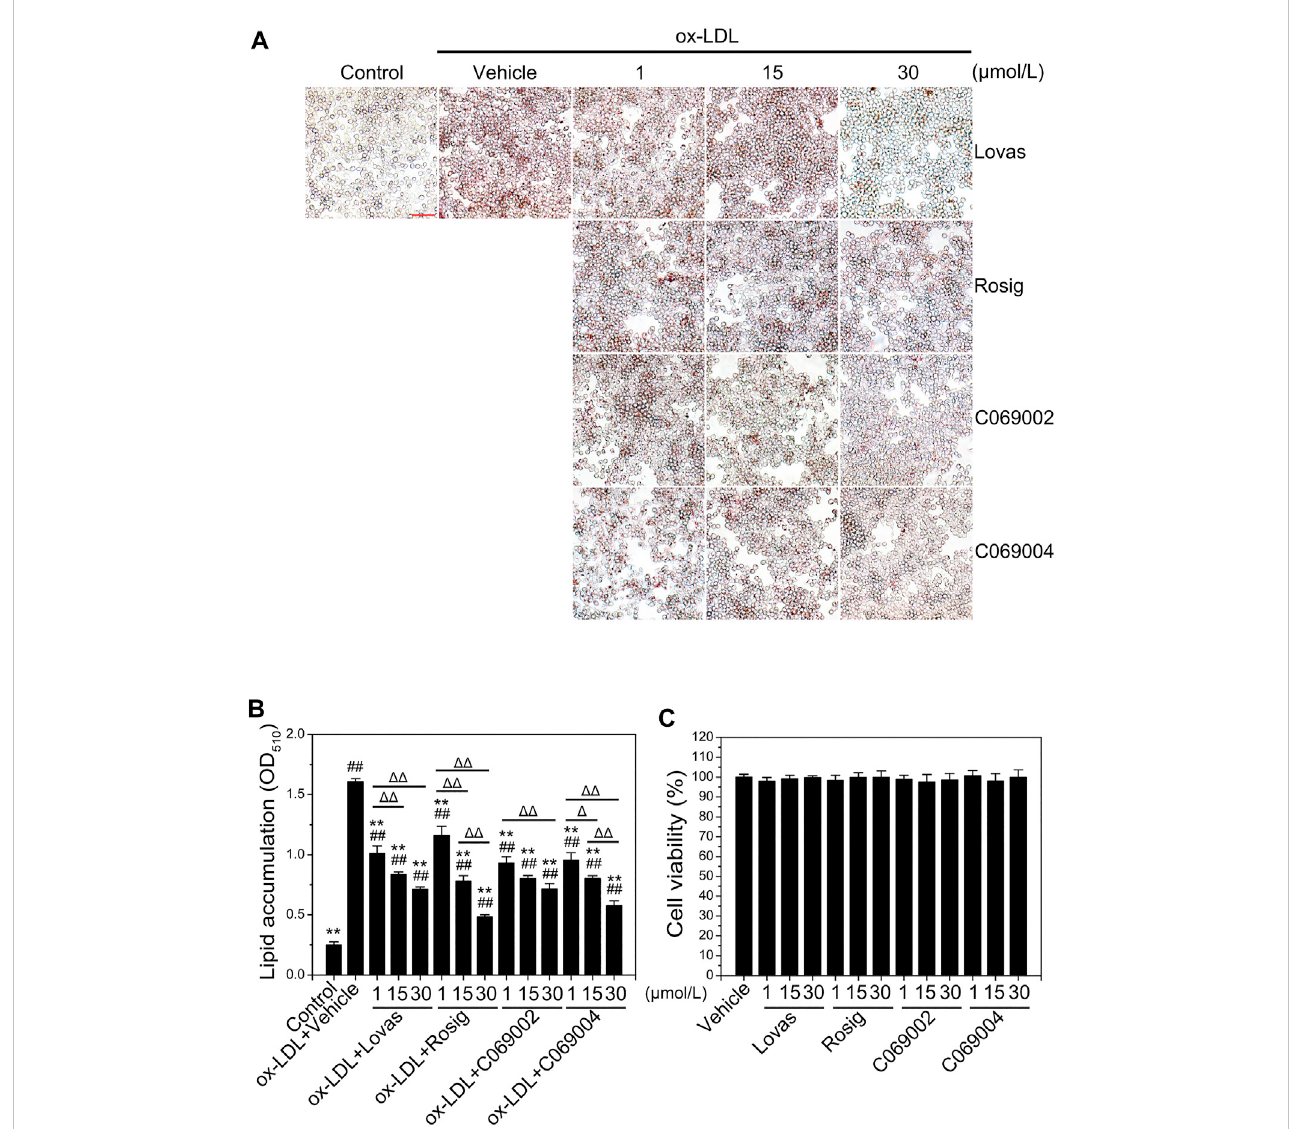
Diterpenoidsalleviateox-LDL-inducedintracellularlipidaccumulationandhavenoeffectonmacrophagecellviability. (A) RAW264.7cellsweretreatedwithox- LDL(80 μ g/mL)anddifferentconcentrationsoflovastatin,rosiglitazoneorditerpenoids(C069002andC069004)for24 h.Lipidaccumulationwasdetermined byoil redO(ORO)staining(×400magni fi cation).Scalebar=50 μ m. (B) QuantitativeresultswereobtainedbymeasuringtheelutedORO (A) usingaspectrophotometer. (C) Diterpenoidshavenoeffectonmacrophagecellviability.RAW264.7cellswereincubatedwithdifferentconcentrationsoflovastatin,rosiglitazoneorditerpenoids (C069002andC069004)respectivelyfor24 handthenincubatedwithMTTforafurther4 h.CellviabilitywasmeasuredbytheabsorbanceofdissolvedMTTcrystals using an ELISA reader. Dataare shownasmean ± SDfrom three independent experiments. Signi fi cance is presented as * p < .05, ** p < .01 versus thevehicle (DMSO) group; # p < .05, ## p < .01 versus the control group, and Δ p < .05, ΔΔ p < .01 between the indicated groups. Lovas: lovastatin; Rosig: